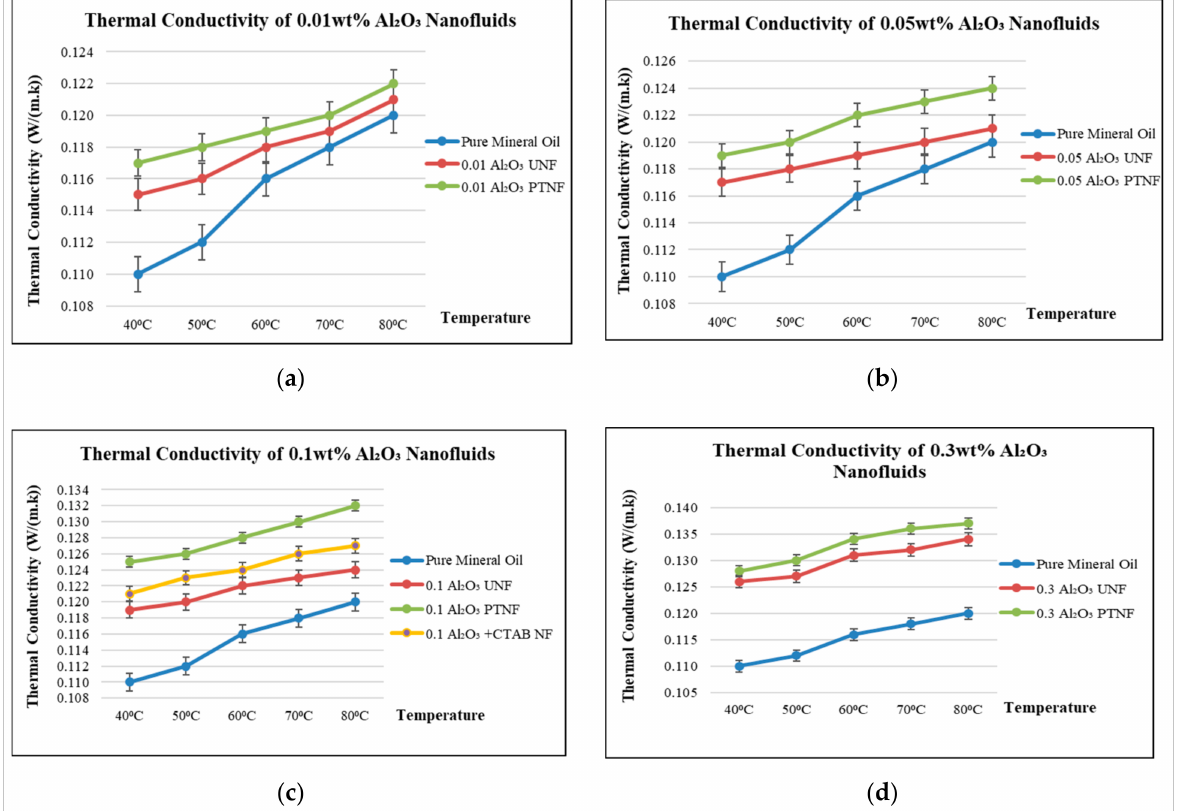
Figure 18. Thermal conductivity results: ( a ) 0.01 wt% Al 2 O 3 nanofluids, ( b ) 0.05 wt% Al 2 O 3 nanofluids, ( c ) 0.1 wt% Al 2 O 3 nanofluids, and ( d ) 0.3 wt% Al 2 O 3